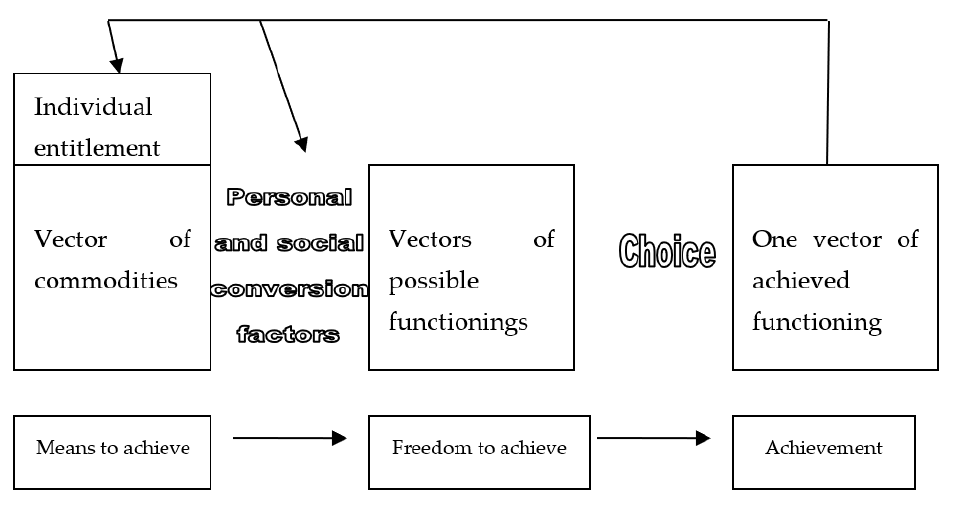
Figure 1. From entitlements and commodities to achieved functionings [9] (p. 134).